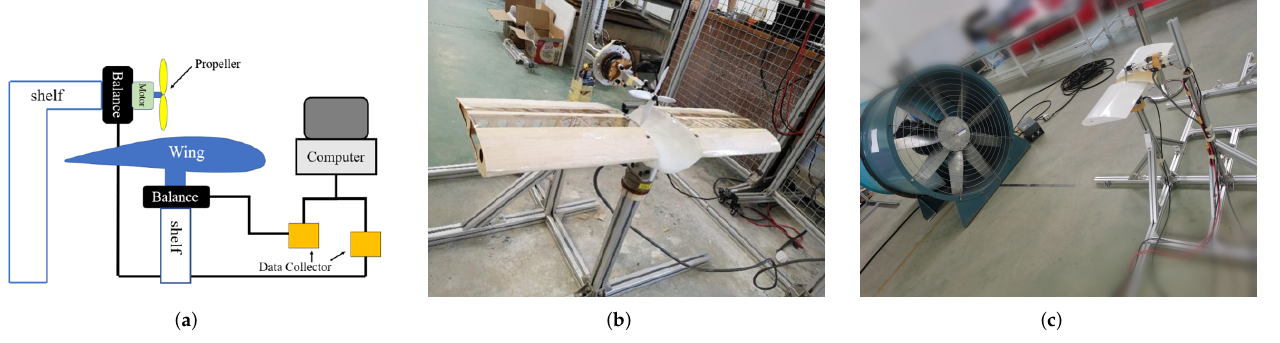
Figure 10. Schematic and photo of ground test. ( a ) Testing System; ( b ) Photo of Static Test; ( c ) Photo of Low-speed